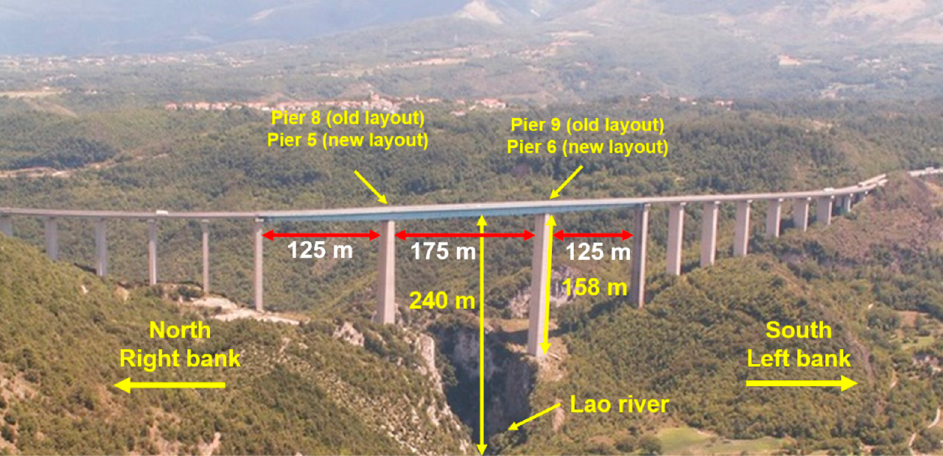
Figure 1. Aerial view of the Viadotto Italia on the A2 Mediterranean Highway (Autostrada del Mediterraneo).